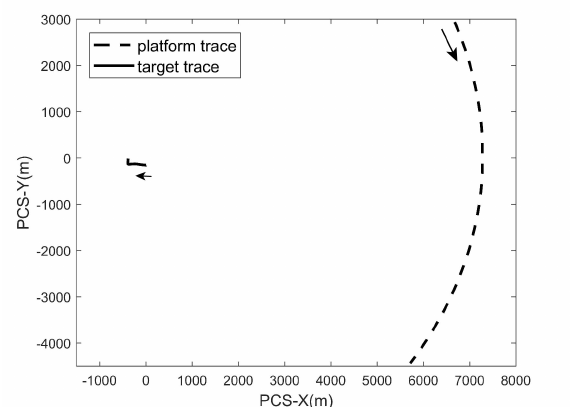
Figure 2. Top view of the platform and target relative motion of the GOTCHA dataset. The arrow indicates the moving direction of target and